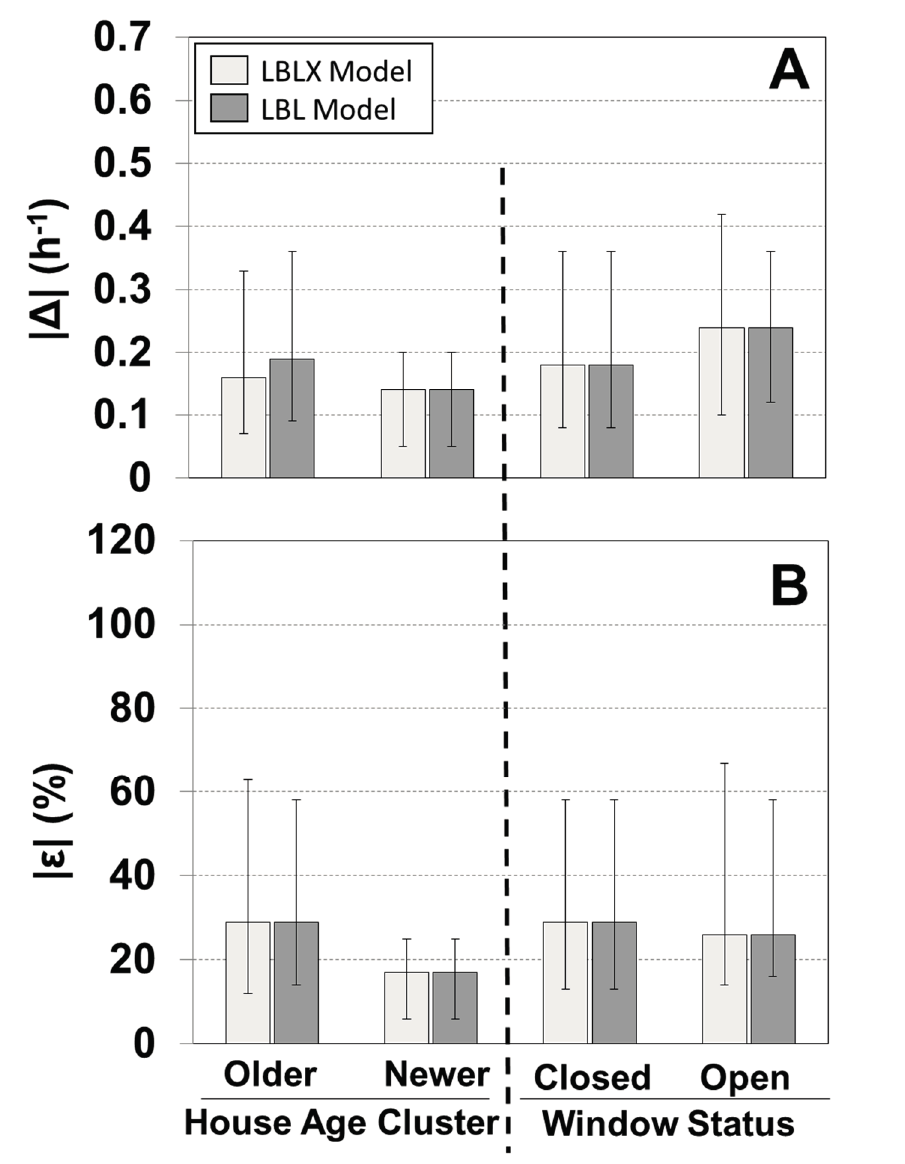
Figure 3. Comparison of absolute differences for | Δ | ( A ) and relative differences | ε | ( B ) between individual modeled and measured AER for the LBLX and LBL